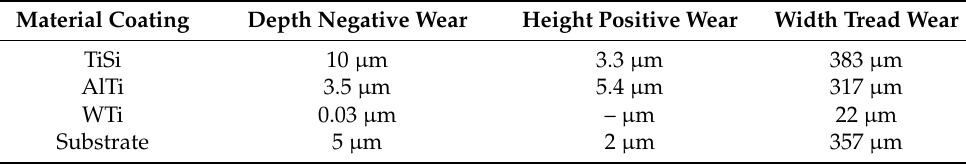
Figure 7. Profile of the wear traces obtained via profilometry: ( a ) TiSi coating, ( b ) AlTi coating, ( c ) WTi coating, and ( d ) AISI 316L steel substrate. Table 3. Characteristics of the wear footprint of coatings and